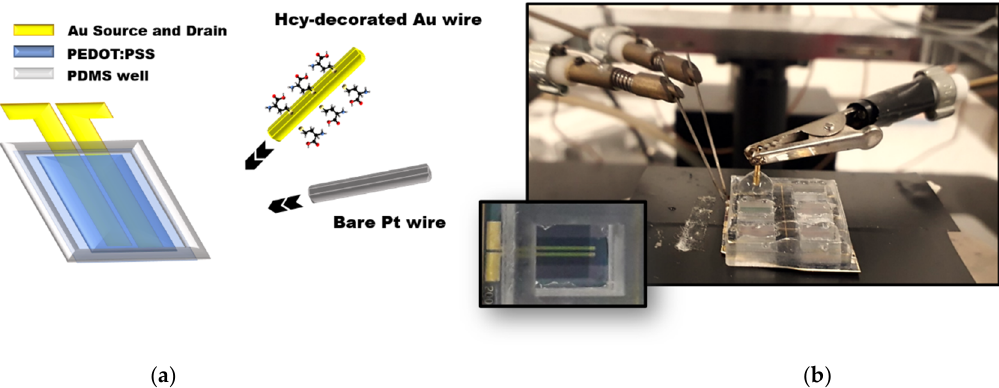
Figure 2. ( a ) Sketch of the OECT layout with Hcy-decorated Au- and bare Pt-gated electrodes used in this study. ( b ) Photograph of the OECT device connected to the probe-tip terminals (source and drain), showing the liquid electrolyte confined in the PDMS well and the Hcy-decorated gold gate electrode immersed in it; the inset shows a top-view picture of the real OECT.